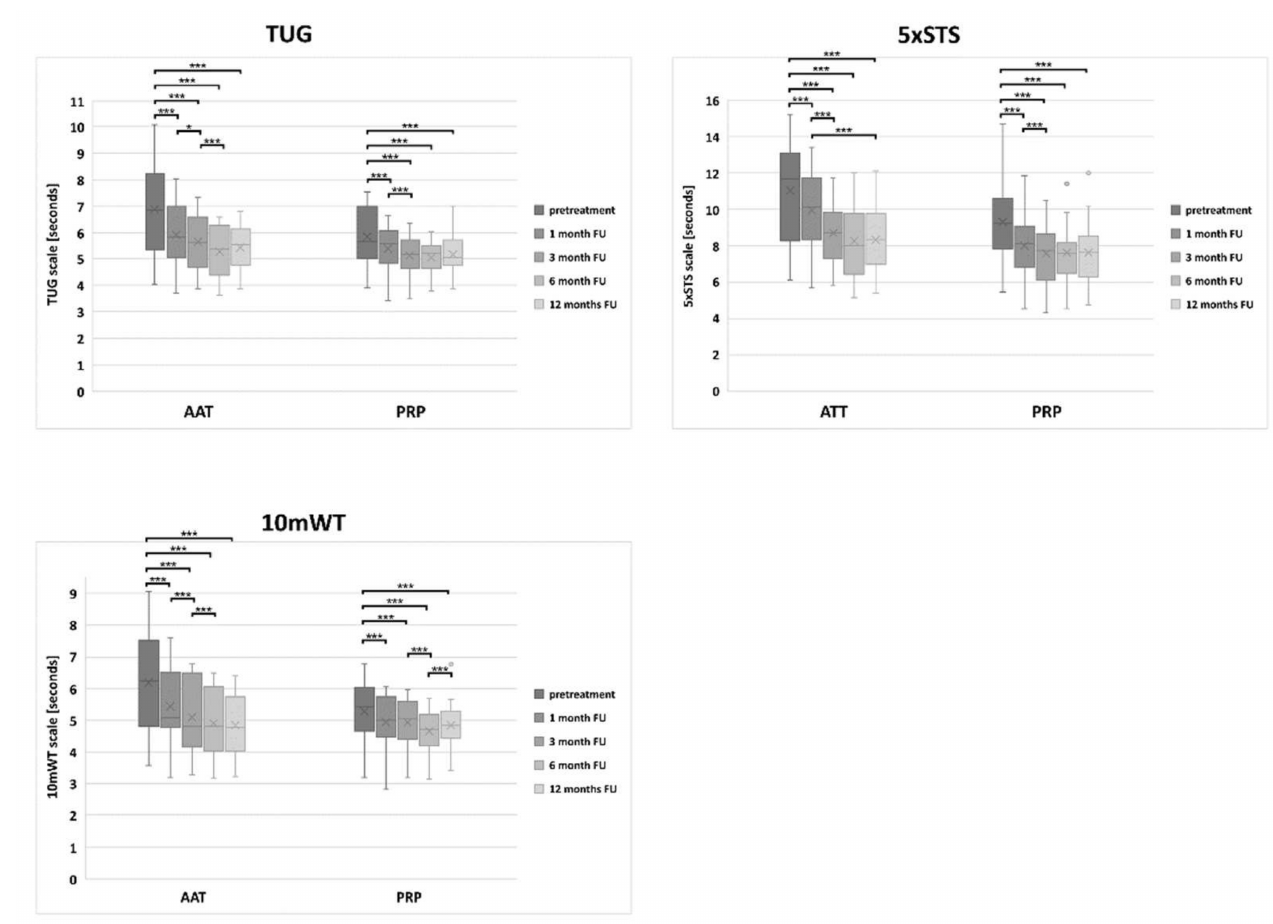
Figure 5. The distribution of the TUG, 5 × STS and 10 mWT score values in the PRP and the AAT treatment groups. Central lines represent the medians, boxes indicate the range from 25th to 75th percentile, whiskers extend 1.5 times above the interquartile range and outliers are represented as dots. The significance was designated as * p < 0.05 and *** p <